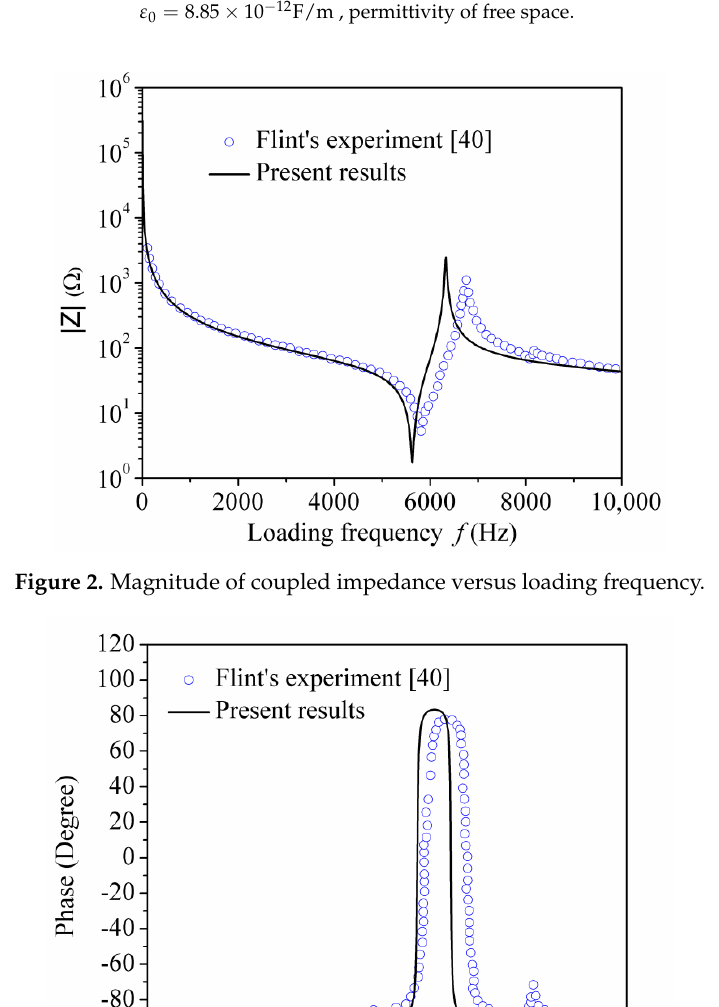
Figure 4. Relationship between the voltage frequency and the output displacement amplitude for different voltage amplitudes. When an external voltage with amplitude